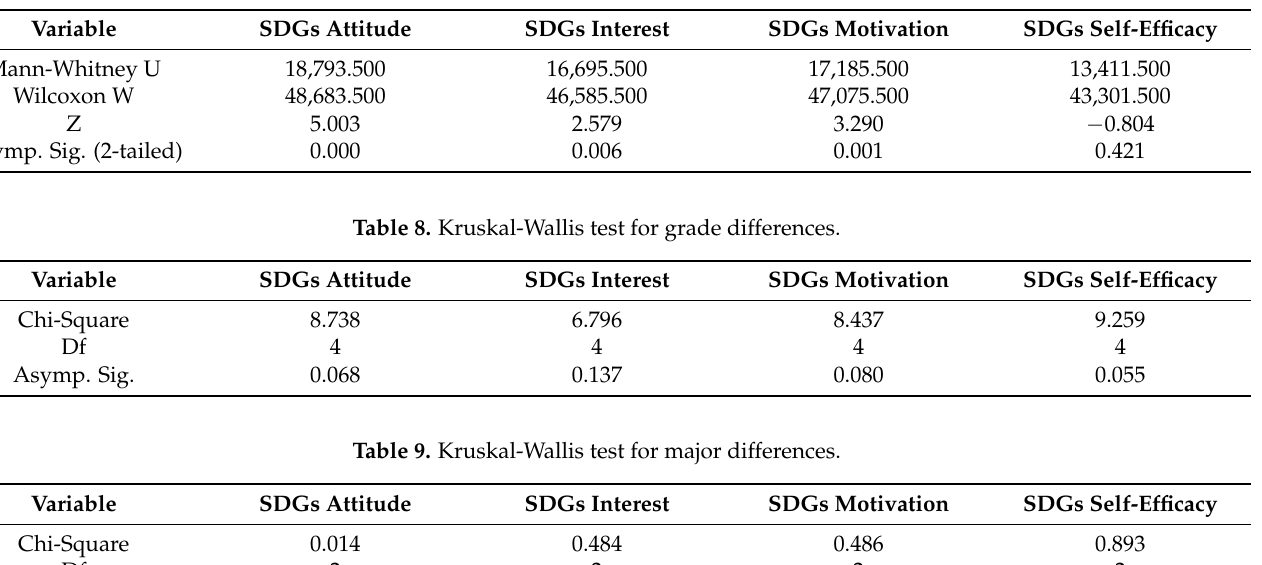
Table 7. Mann-Whitney U test for gender differences.